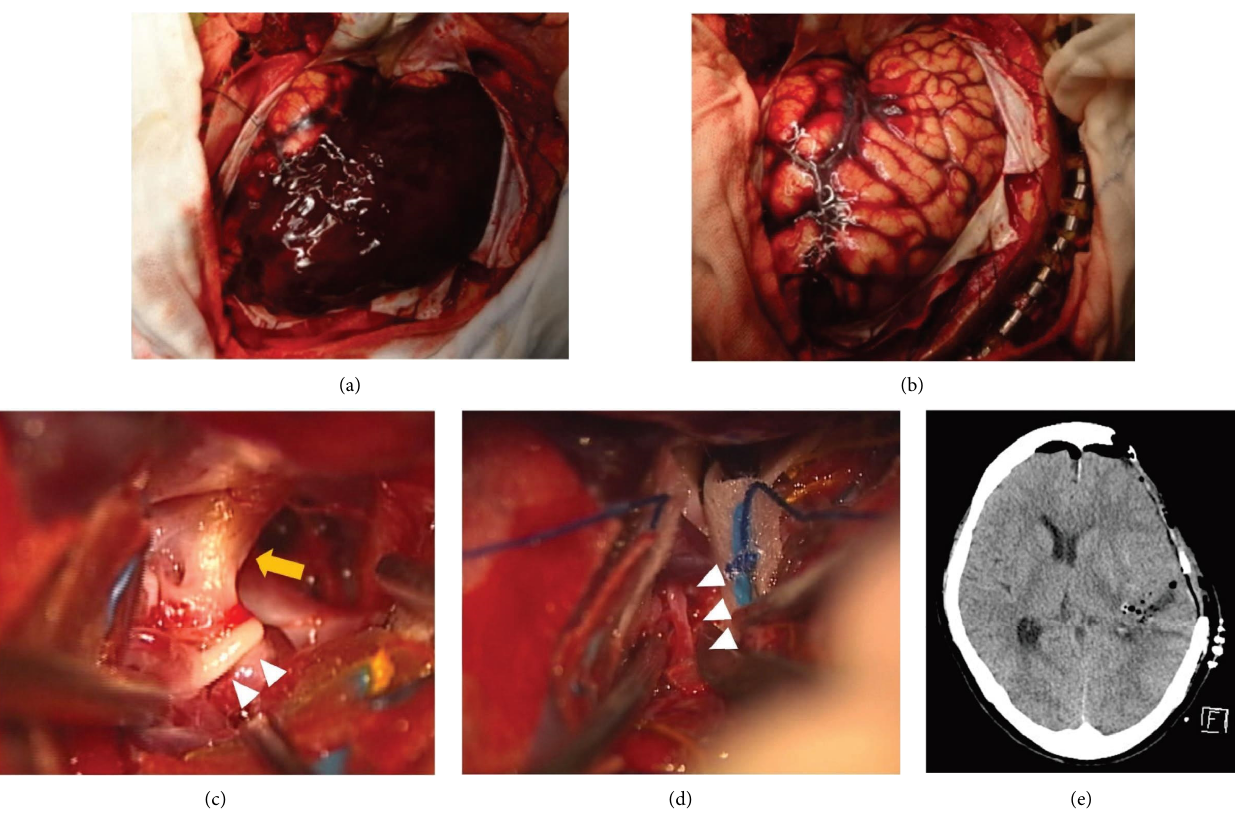
Figure 2: Images of the initial procedure. (a) Photograph showing a huge subdural hematoma after opening the dura mater. (b) Photograph after evacuation of the hematoma showing a swollen brain surface. (c) Intraoperative microscopic photograph showing the left internal carotid artery (arrow) and M1 segment of the hypoplastic left middle cerebral artery (MCA) (arrowheads). (d) Intraoperative microscopic showing a narrow M2 segment of the hypoplastic left MCA (arrowheads). (e) Computed tomography immediately after surgery, confrming adequate decompression and removal of the